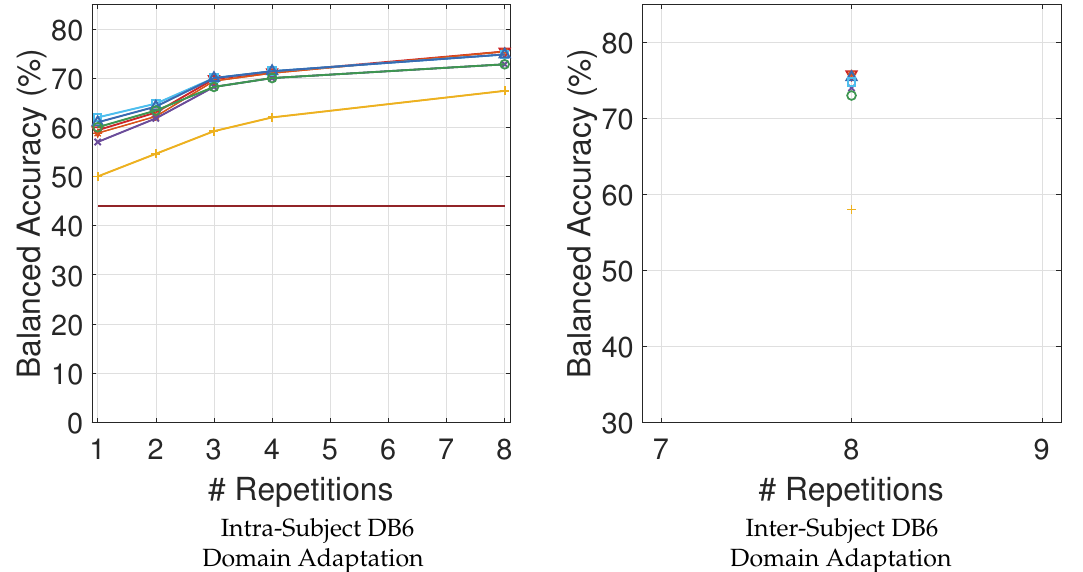
Figure 5. DB6 Results: intra-subject and inter-subject balanced classification accuracy as a function of number of training repetitions on